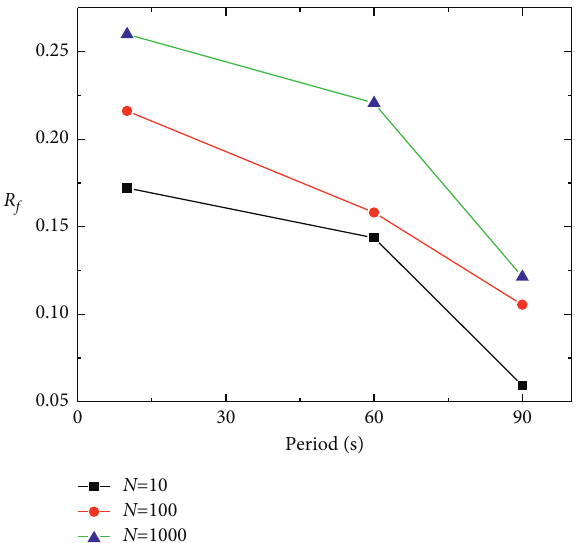
Figure 11: Shear strength ratio of sliding zone soil at different cycle periods ( σ